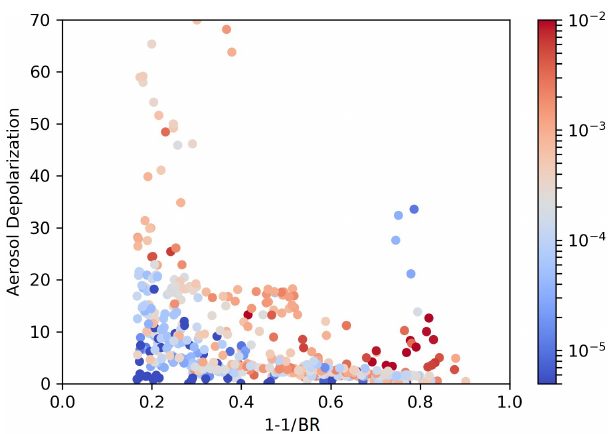
Figure 1. Scatterplot of aerosol depolarization vs. 1 − 1 / BR, where BR is the backscatter ratio. Data are from McMurdo lidar and Kiruna balloon flights backscattersonde, coincident with balloon- borne OPC PSD measurements, fitted with mono- or bimodal log- normal distributions. The colour codes the fraction of particles with radius larger than 1µm with respect to the total number of particles in the PSDs. We report data points with BR greater than 1.2, β cross greater than 5 × 10 − 6 km − 1 sr − 1 and temperature at the observa- tion below